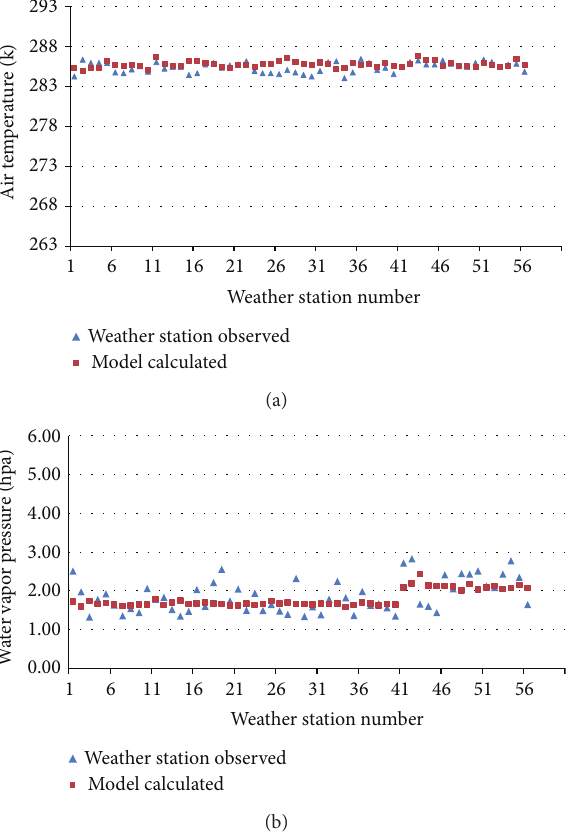
Figure 3: Comparison of modeled and observed surface air tem- perature (a) and water vapor pressure distribution (b) over the meteorological